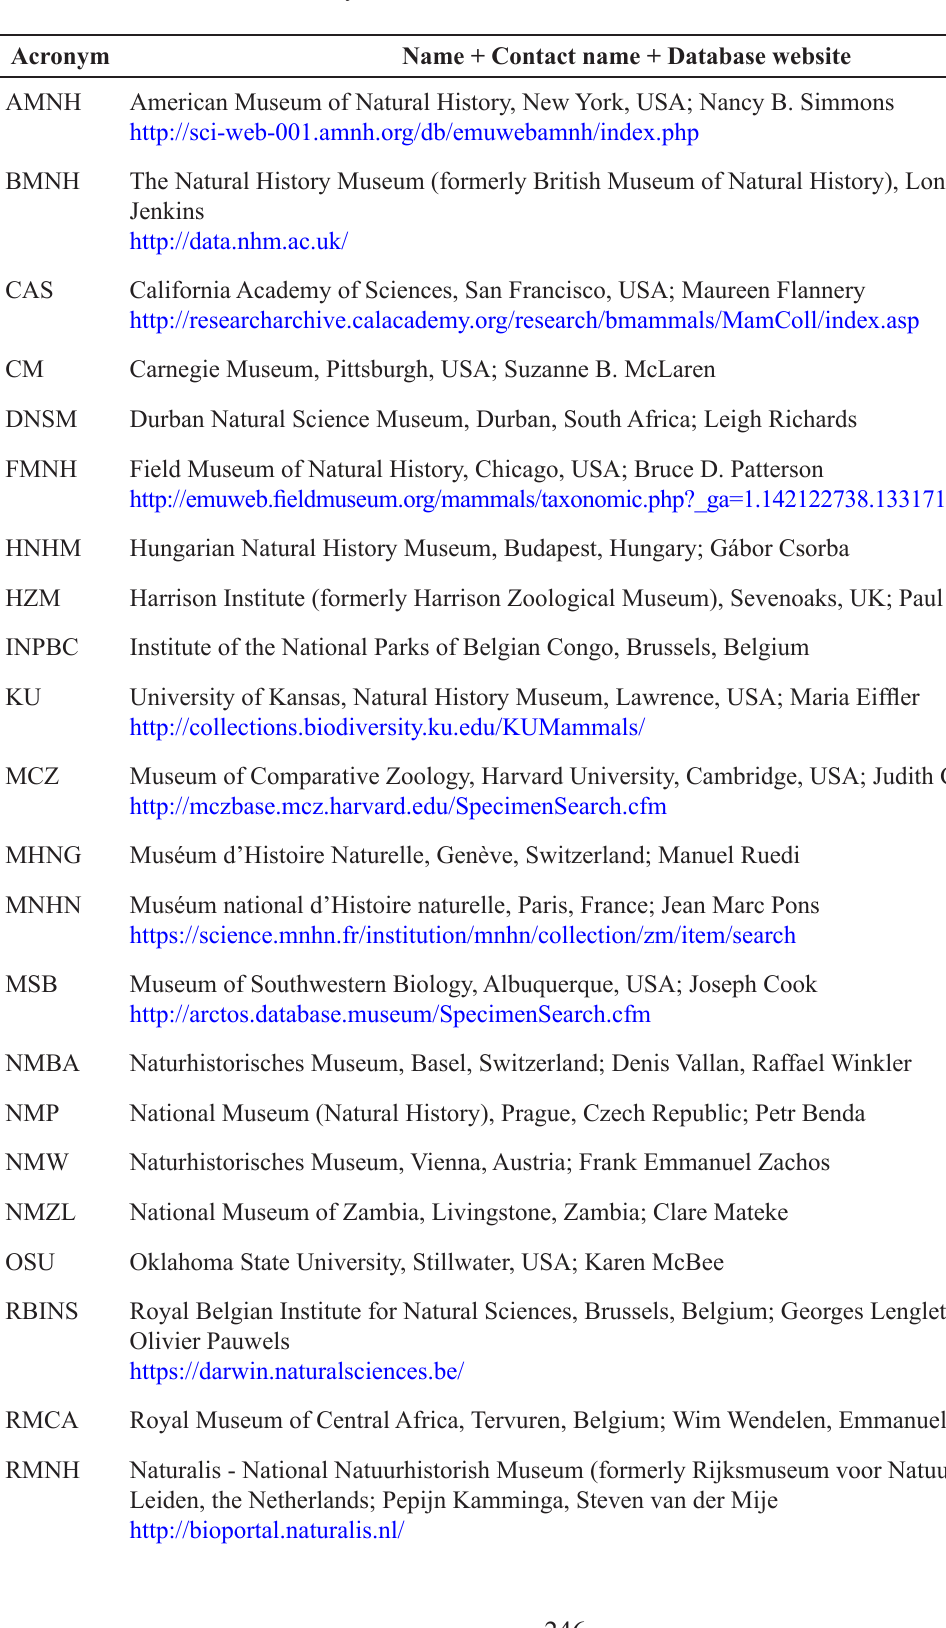
Summary table of museum specimens Overview of the museum